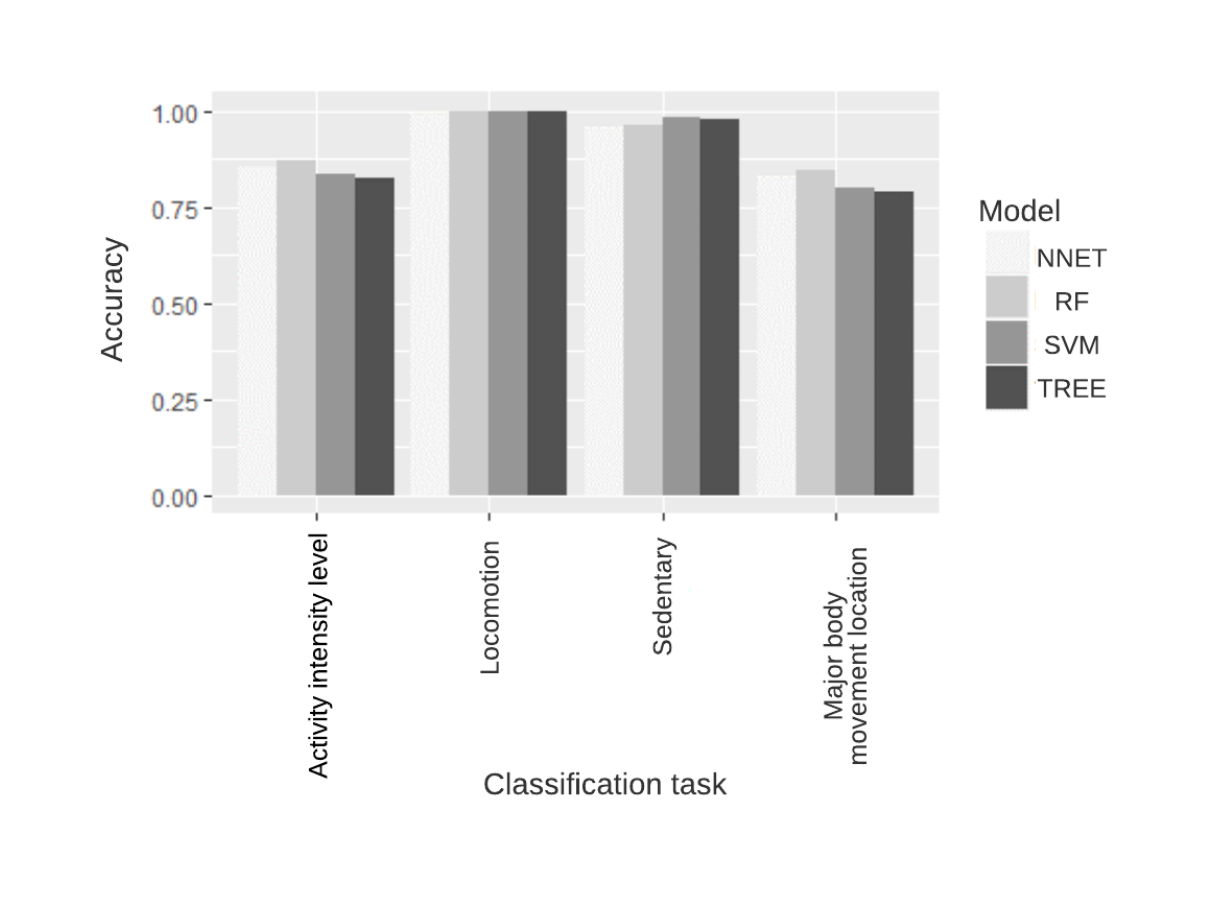
Figure 11. Performance of 4 classifier models in activity type classification tasks in terms of accuracy. NNET: neural networks model; RF: random forest model; SVM: support vector machines model, TREE: decision trees